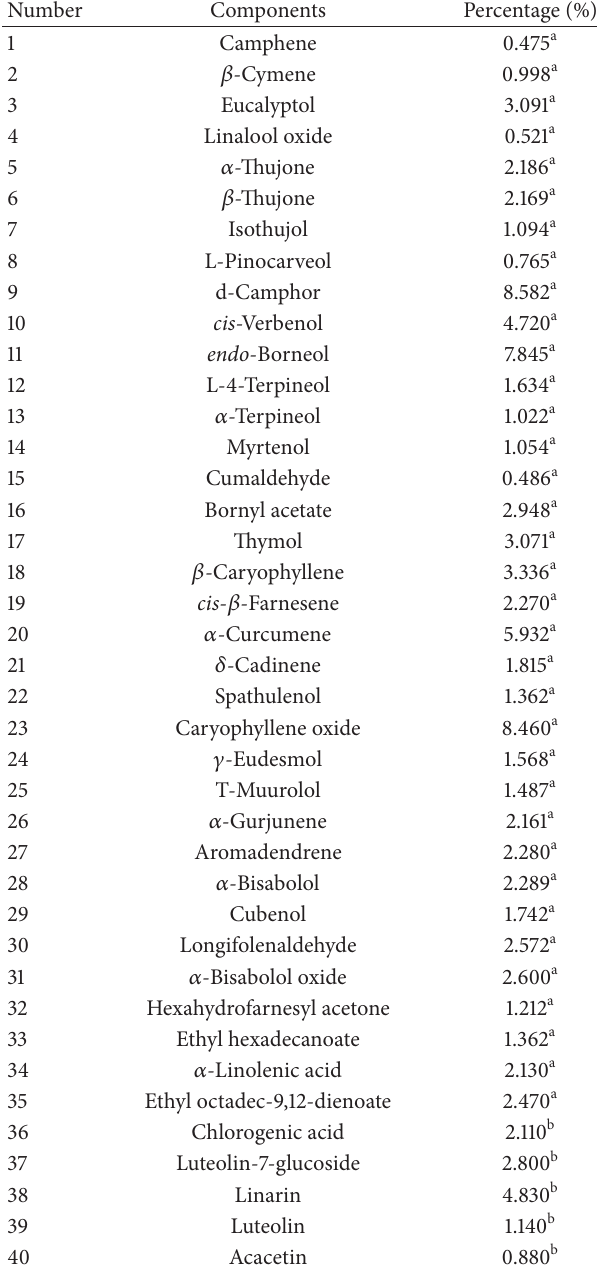
Table 1: The chemical profile of